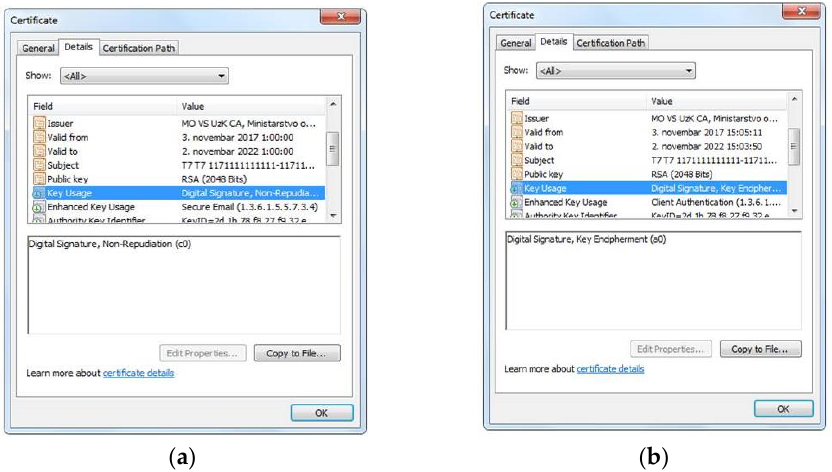
Figure 5. Digital certificates for end user. ( a ) Digital certificate for electronic signature; ( b ) Digital certificate for encryption.